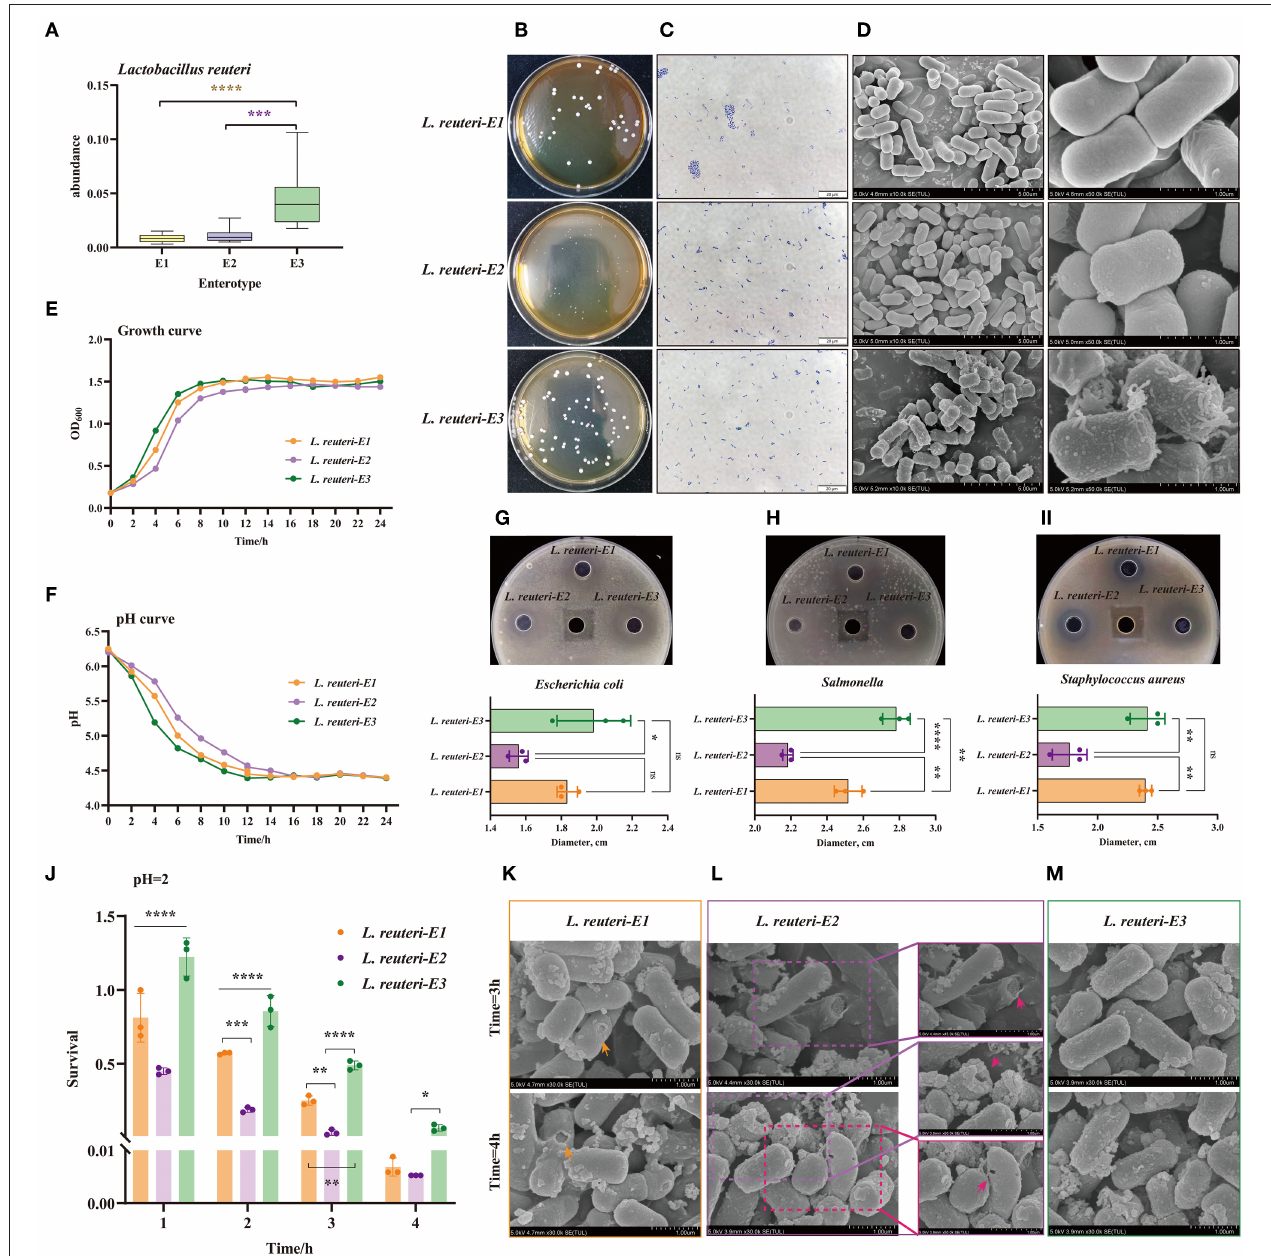
FIGURE 6 | Screening and function exploration of E3 representative strain Lactobacillus reuteri ( L. reuteri ) among three enterotypes. (A) The abundance of L. reuteri in three Enterotypes. (B) Photograph of the plate, (C) Gram stain, and (D) SEM pictures of L. reuteri isolated from the three enterotypes. The magnification is 10.0k. (E) Growth curve analysis of three strains of L. reuteri . (F) Comparison of the acid production capacity of three strains of L. reuteri . The inhibition against (G) Escherichia coli , (H) Salmonella , and (I) Staphylococcus aureus . (J) Comparison of the survival rates of the three types of L. reuteri under the condition of pH = 2. Scanning electron microscope (SEM) picture of the destruction of the outer membrane of (K) L. reuteri -E1, (L) L. reuteri -E1, and (M) L. reuteri -E3. * P < 0.05; ** P < 0.01; *** P < 0.001; **** P < 0.0001.